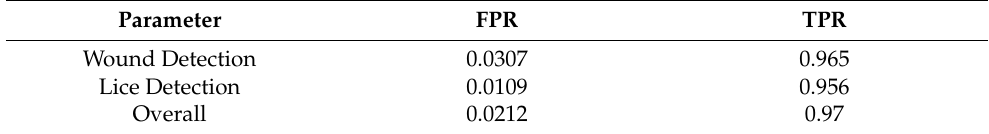
Table 1. The FPR and TPR for wound and lice detection.